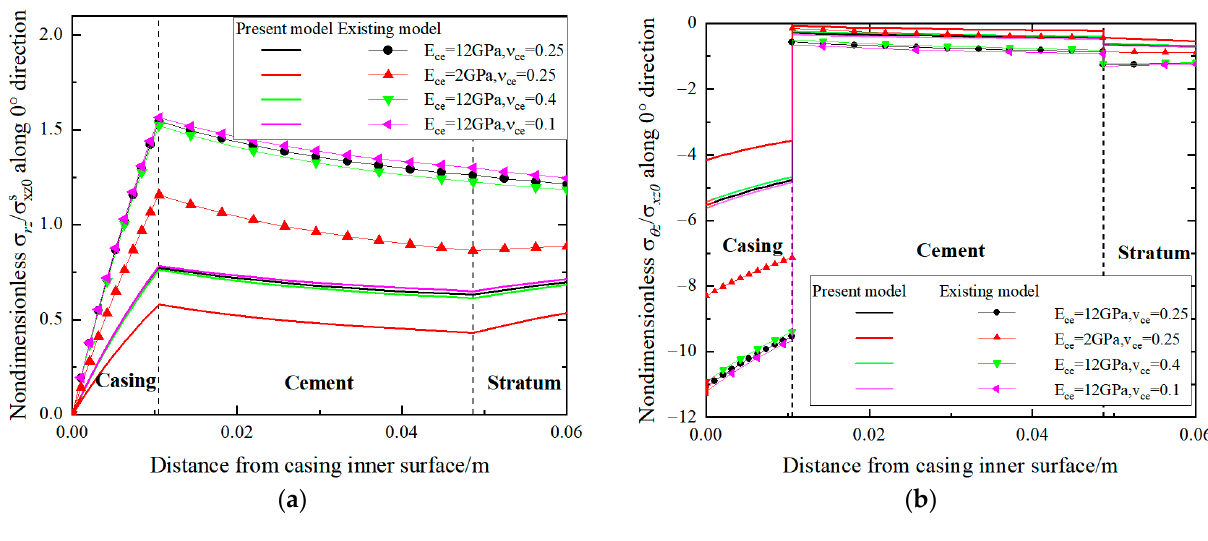
σ σ σ σ distribution along / s / s ; ( b ) nondimensionless 0 rz xz 0 z yz θ σ σ ; ( b ) nondimensionless σ σ distribution along / s / s ; ( b ) nondimensionless σ θ z / σ s distribution along 0 ◦ direction. 0 z yz θ 0 rz xz xz 0 yz 0